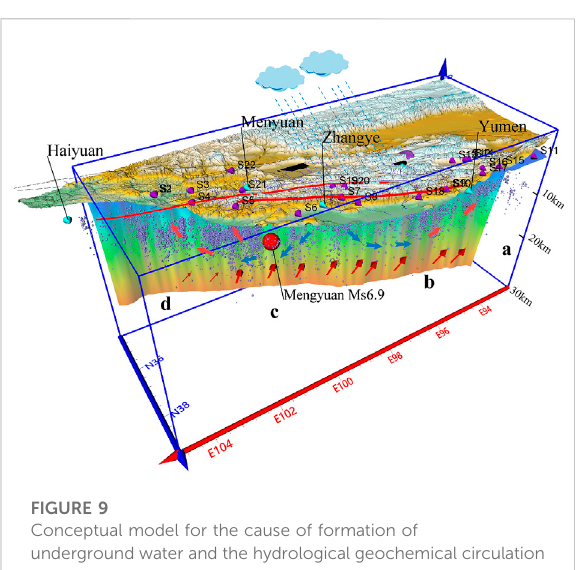
FIGURE 9 Conceptual model for the cause of formation of underground water and the hydrological geochemical circulation